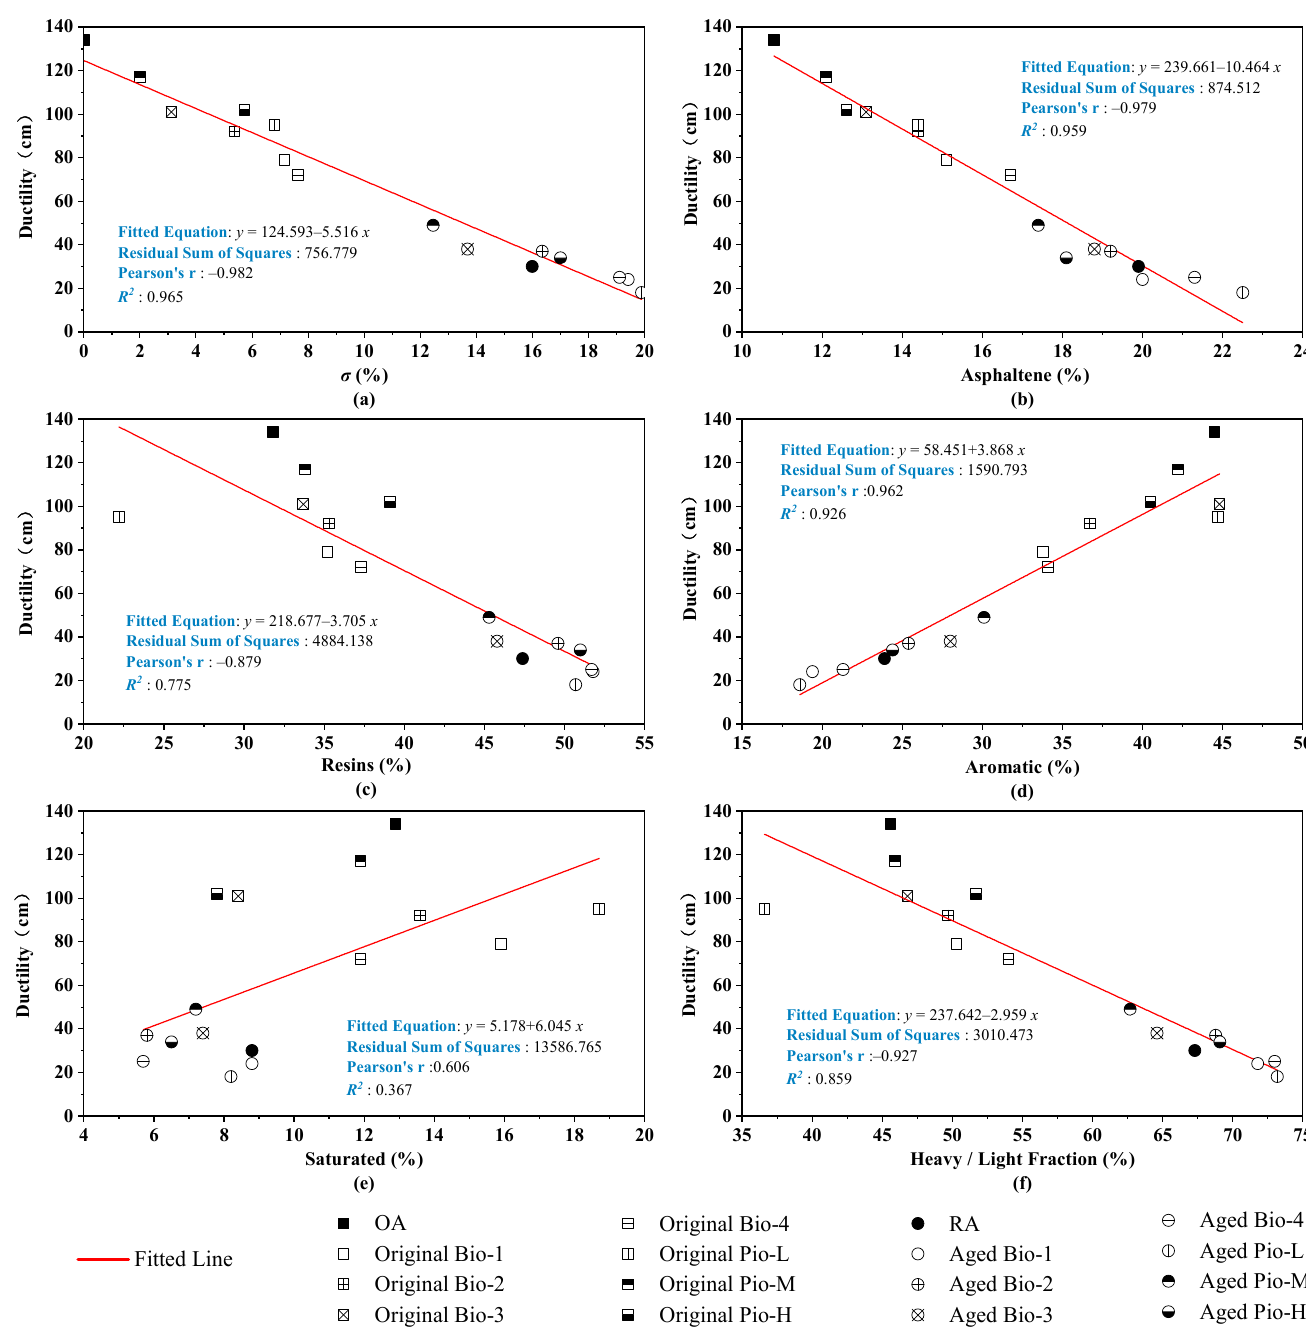
Figure 18. Correlation analysis between ductility and fraction indicators. ( a ) σ ; ( b ) asphaltene; ( c )resins; ( d ) aromatic; ( e ) saturated; ( f ) heavy/light.